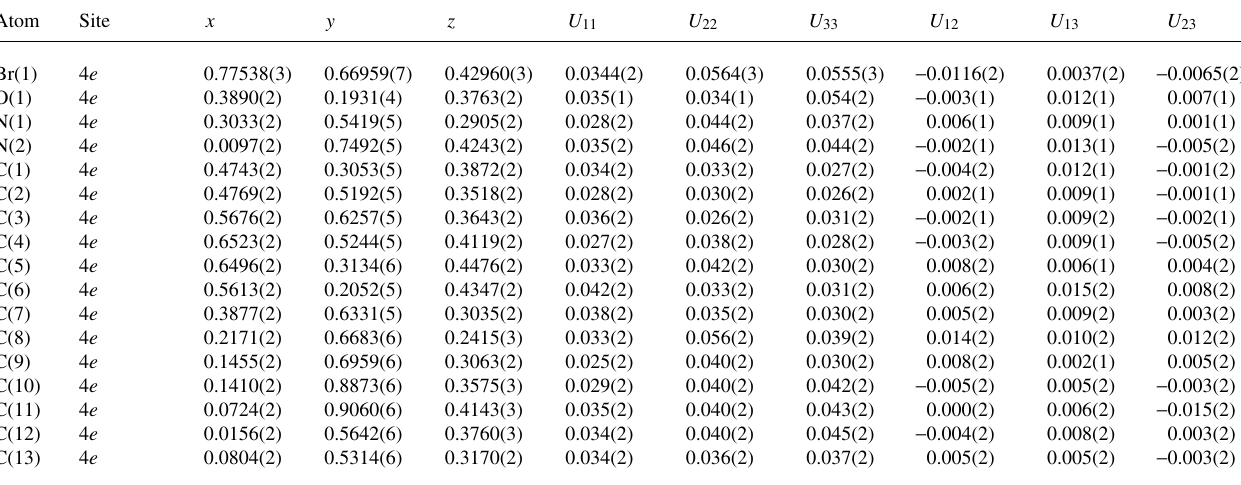
Table 3. Atomic coordinates and displacement parameters (in Å 2 )